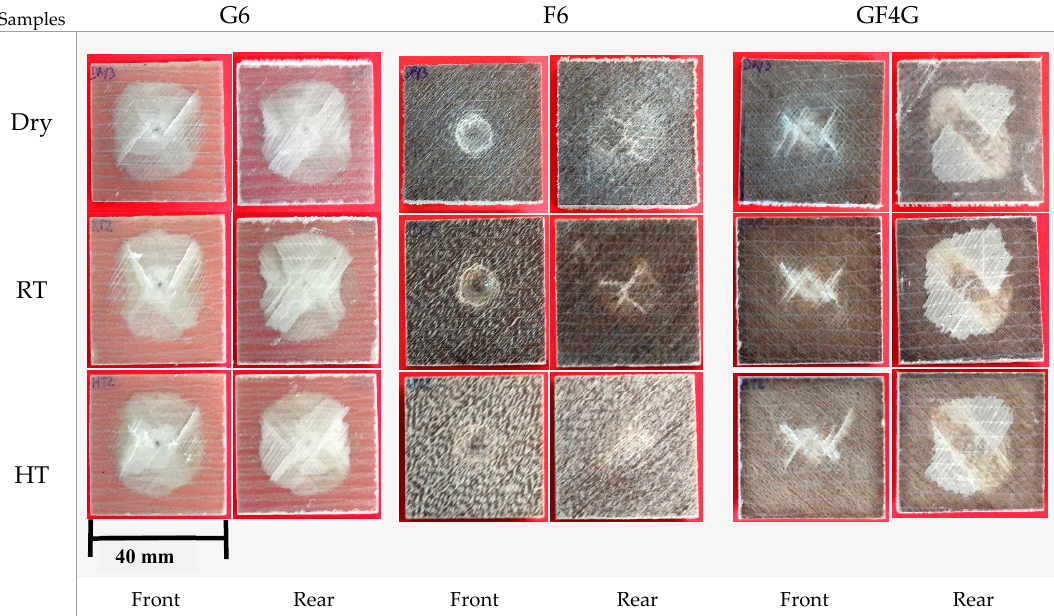
Figure 5. Pictures of dry, RT immersed and HT immersed glass fibre, flax fibre and hybrid specimen impacted at 25 J.